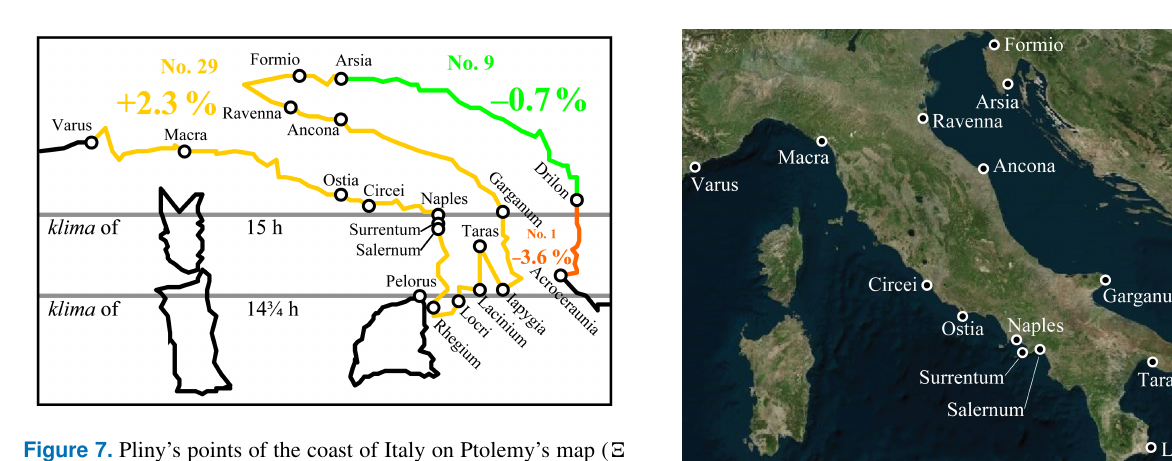
Figure 7. Pliny’s points of the coast of Italy on Ptolemy’s map ( (cid:52) recension). The percentages refer to the deviation of Ptolemy’s val- ues for the coastline length from those given by Pliny (no. 29 in Table 1) and Agrippa (nos. 1 and 9).